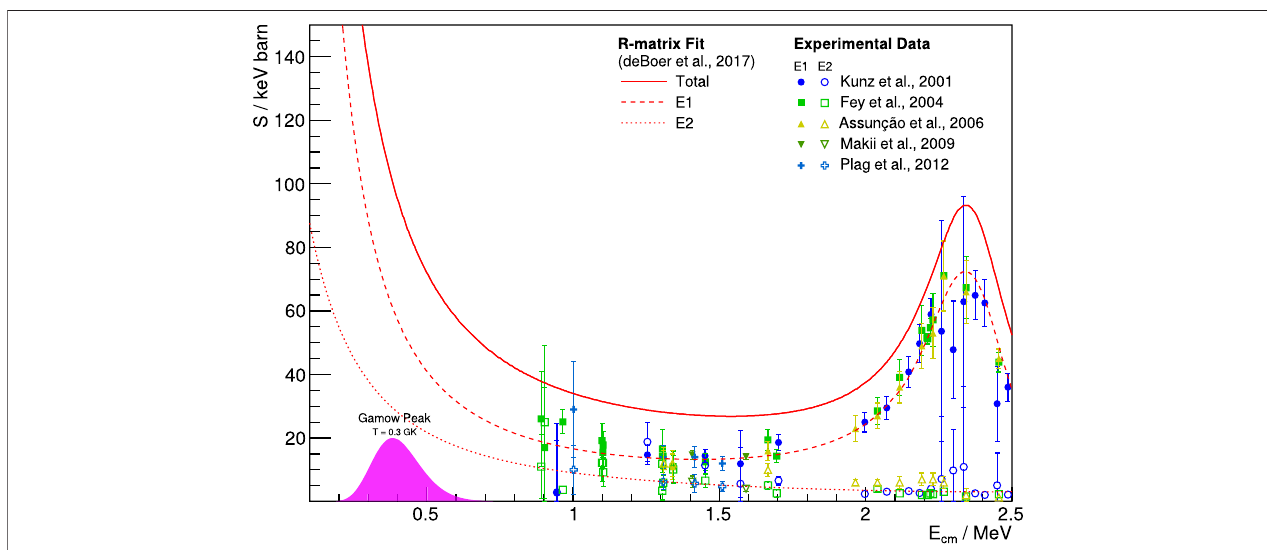
FIGURE 8 | Overview of recent experimental data (Kunz et al., 2001; Fey, 2004; Assunção et al., 2006; Makii et al. 2009; Plag et al., 2012) for the ground state capture in 12 C( α , c ) 16 O, with the results of R-matrix fi ts from deBoer et al. (2017) for comparison. All data are unscaled. The location of the Gamow window for a stellar temperature of 0.3 GK is shown for